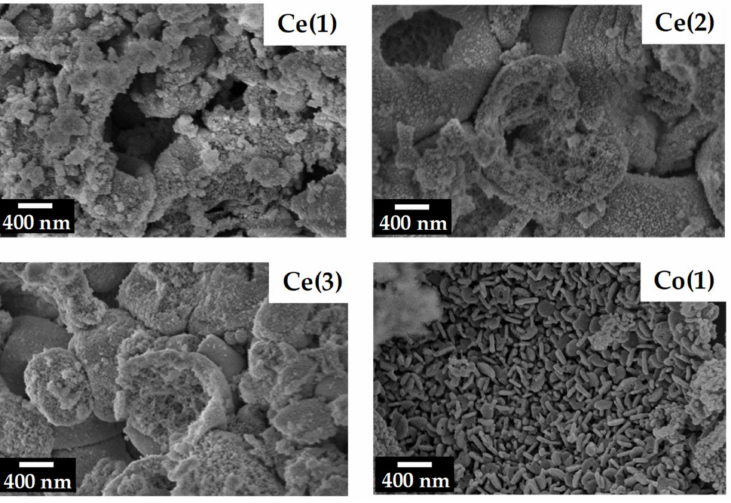
Figure 1. SEM images of CeO 2 and Co 3 O 4 synthesized particles (Table 1).